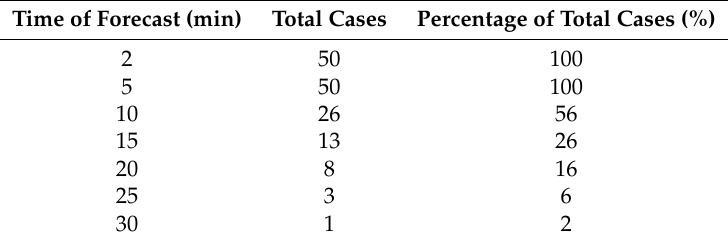
Table 2. Time total of the clouds in